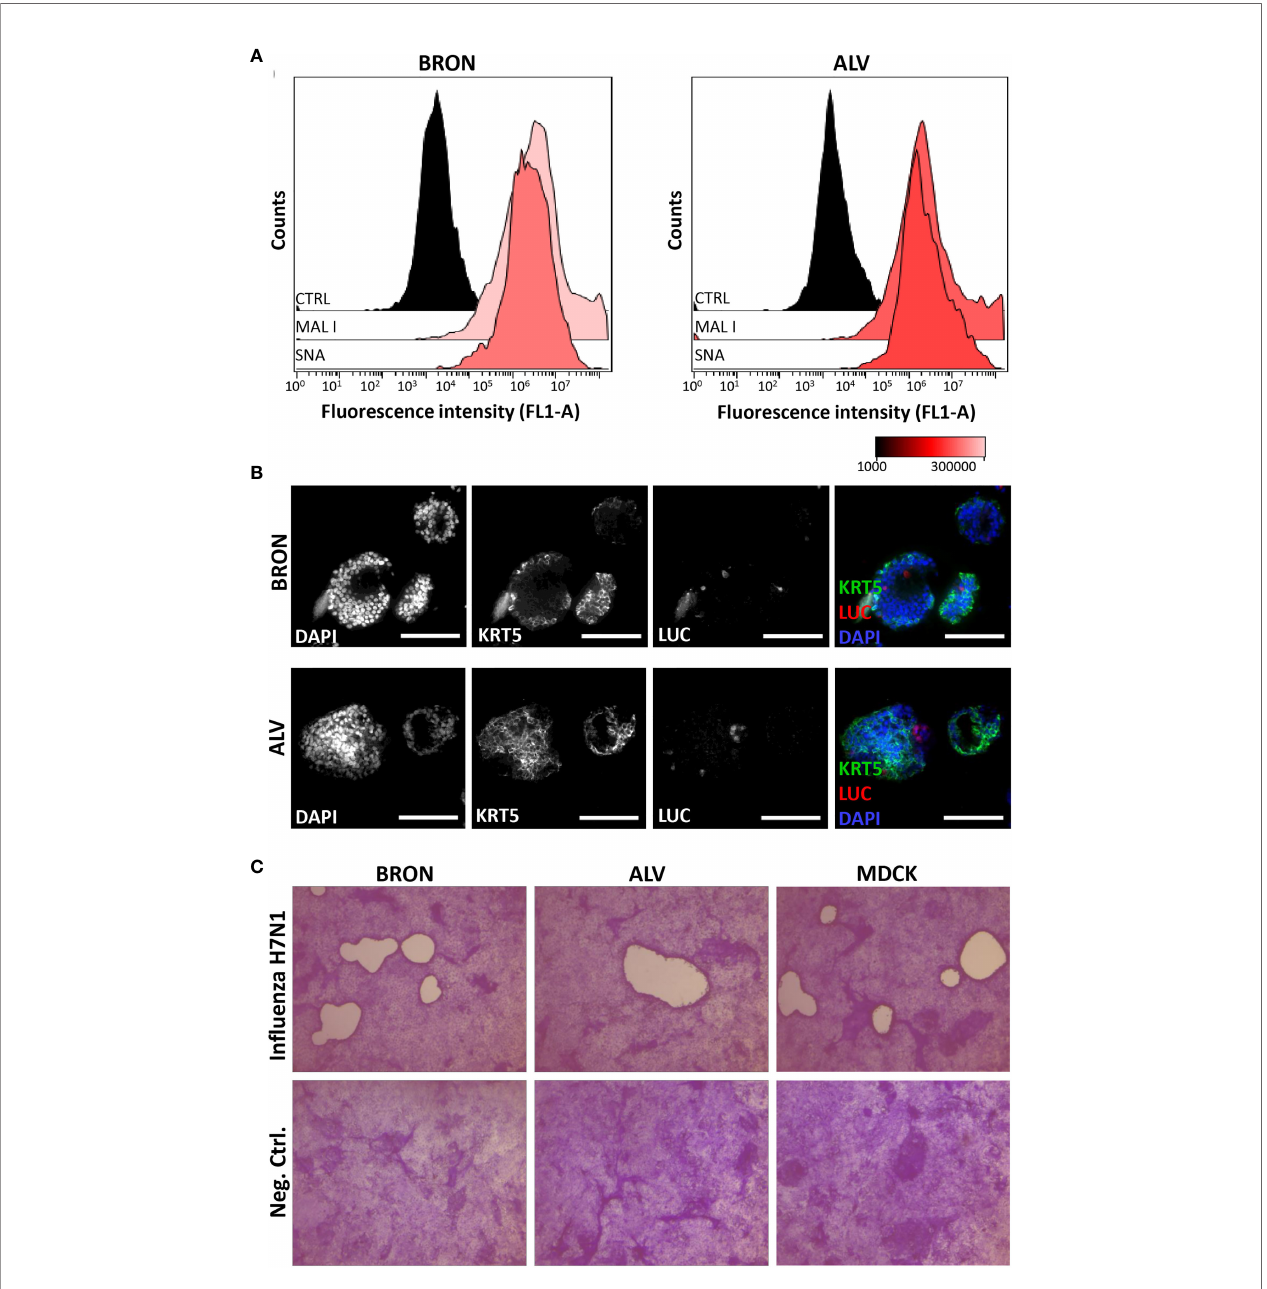
FIGURE 5 | Detection of essential in fl uenza virus receptors entry factors in organoids and infection by in fl uenza pseudotype H5N1 and viral replication by H7N1 virus. (A) Sialic acids (SAs) of cell surface glycoproteins and glycolipids are the receptors for in fl uenza virus. The presence of SAs and galactose on bronchiolar (BRON, left histograms) and alveolar (ALV, right histograms) were detected by fl ow cytometry using the fl uorescein-conjugated lectins, MAL I, recognizing galactose, and SNA, recognizing a 2,6-linked sialic acids. CTRL histogram represents the unstained control cells. The representative fl ow cytometry histograms shown here were from stained dissociated organoids from patient L2. (B) In situ detection of cells infected by the pseudotyped luciferase expressing H5N1 in fl uenza virus was done by immunostaining to detect luciferase (LUC) and keratin 5 (KRT5) in formalin fi xed paraf fi n embedded (FFPE) sections of infected organoids. Organoids of BRON (upper panel) and ALV (lower panel) organoid cultures are shown. Sections are counterstained with DAPI. Scale bar in all images equals 100 µm. (C) Organoids were infected with the replicating in fl uenza virus H7N1 strain at an estimated multiplicity of infection (MOI) of 7. Plaque assay was used to con fi rm ef fi cient replication of pseudotyped in fl uenza virus in the organoid cultures. Infected MDCK cells were used as a positive control in this assay. Plaques are visible in MDCK cell cultures inoculated with conditioned media harvested from infected bronchiolar and alveolar organoid cultures, as well as conditioned media harvested from the positive control MDCK cells. Conditioned media from uninfected controls showed no sign of plaque formation (lower row). Counterstaining by crystal violet. Magni fi cation equals